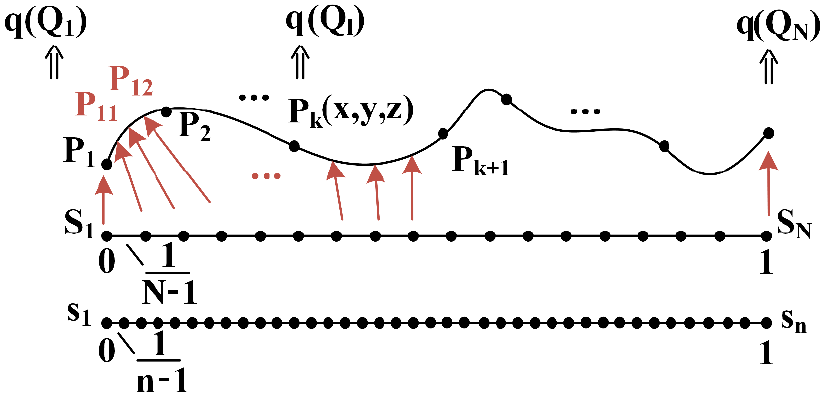
Figure 2. Correspondence relations diagram of path points and generalized path curve parameters. When the path curve proportion variable s chosen is different from the generalized path curve parameter S , we just need to determine which segment s belongs to. The trajectory function q i ( s j ) and derivative q (cid:48)